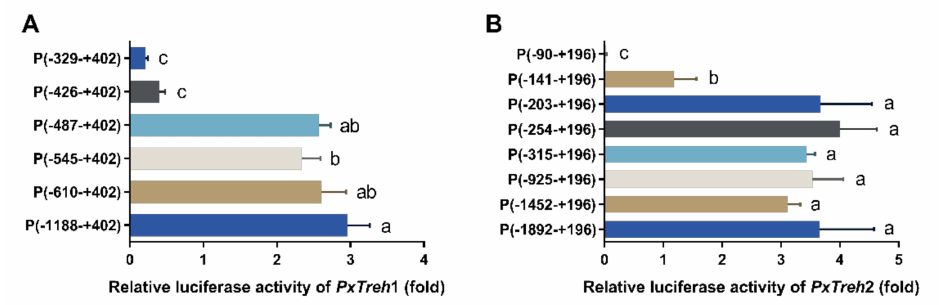
Figure 4. Detection of promoter activity by a dual-luciferase reporter assay. ( A ) The activity of progressive 5’ deletion of the recombinant PxTreh 1 promoters between − 1188 to − 329. ( B ) The activity of the recombinant PxTreh 2 promoters continuously cut from − 1892 to − 90. Values with the same letters are significantly different at p < 0.05 (Tukey’s honest significance test).